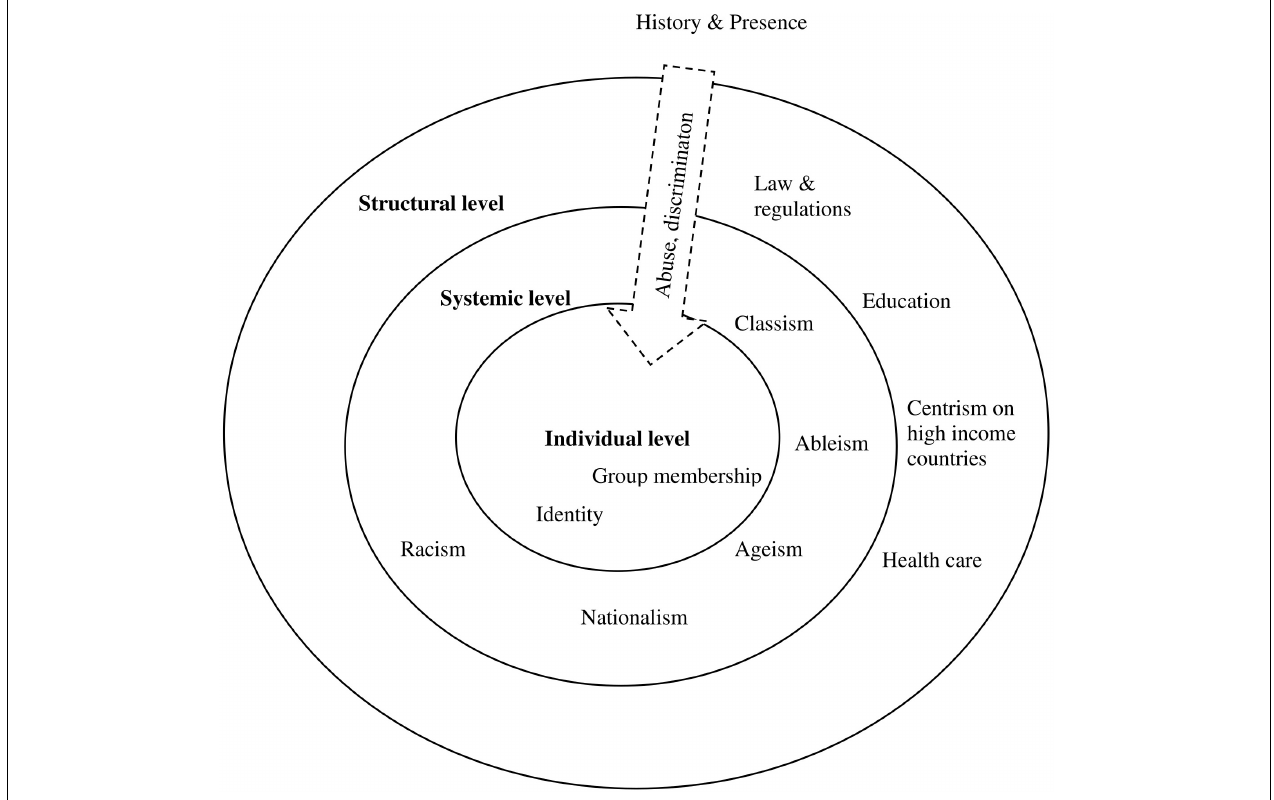
FIGURE 2 | Impact on vulnerability across